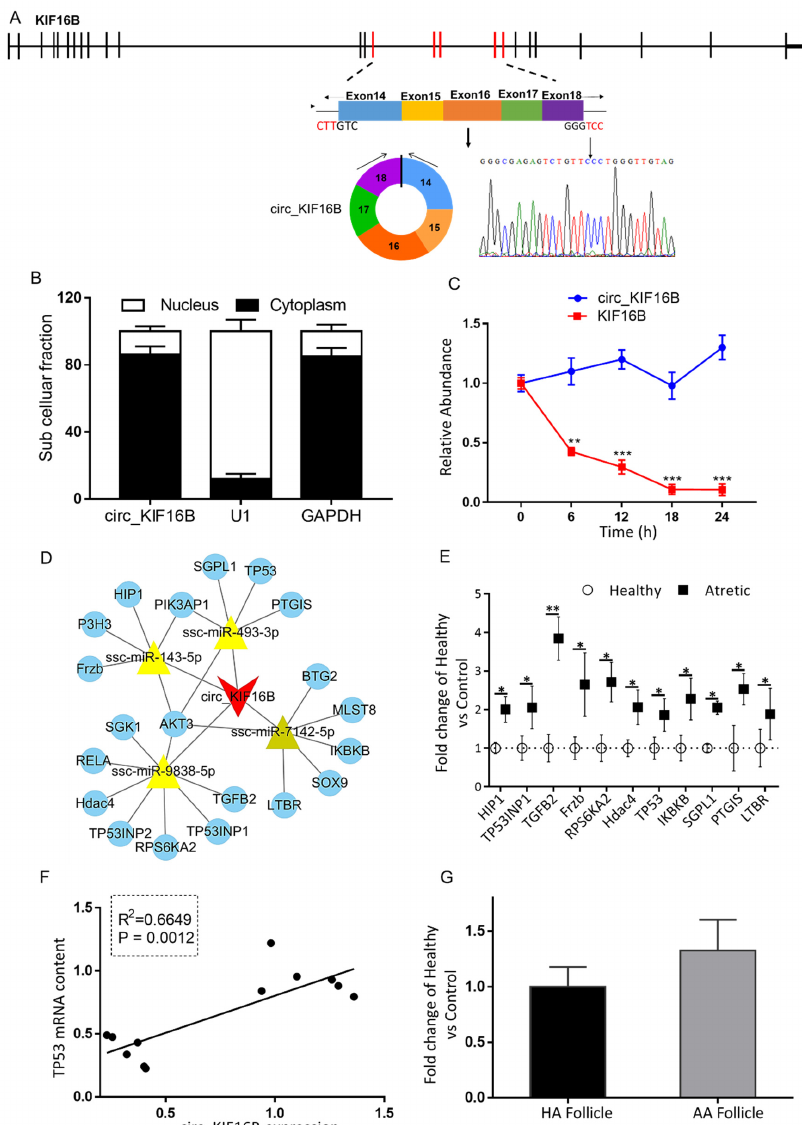
Figure 6. Characterization and putative role of circ_KIF16B. ( A ) The genomic loci of circ_KIF16B in the KIF16B gene. The expression of circ_KIF16B was validated by qRT-PCR, followed by Sanger sequencing. Arrows represent divergent primers binding to the genome region of circ_KIF16B. ( B ) Cellular characterization of circ_KIF16B. Levels of nuclear control transcript (U1), cytoplasmic control transcript (GAPDH and mRNA), and circ_KIF16B were assessed by qRT-PCR in nuclear ( n = 3) and cytoplasmic fractions ( n = 3) of porcine granulosa cells. Data are presented as a percentage of U1, GAPDH, and circ_KIF16B levels. ( C ) qRT-PCR for the abundance of circ_KIF16B (blue line, n = 3) and KIF16B mRNA (red line, n = 3) in granulosa cells treated with actinomycin D at the indicated time points. ( D ) A putative ceRNA network of circ_KIF16B constructed by Cytoscape 3.8. The red V shape represents circ_KIF16B, the yellow triangle represents targeted miRNAs, and blue round circles denote targeted mRNAs. ( E ) qRT-PCR for the abundance of mRNA content of 10 targeted pro-apoptotic genes in granulosa cells of HA (open circles, n = 6) and AA (filled squares, n = 6) follicles. ( F ) Correlation of expression levels of circ_KIF16B and TP53 . ( G ) circ_KIF16B expression in cumulus cells of HA (black bar, n = 6) and AA follicles (grey bar, n = 6), as measured by qRT-PCR. Gene expression, as fold change of AA over HA follicles, with no change, was indicated as 1. KIF16B , kinesin family member 16B; *, p < 0.05; **, p < 0.01. Follicles were isolated in batches at three di ff erent time points, each batch containing 15–20